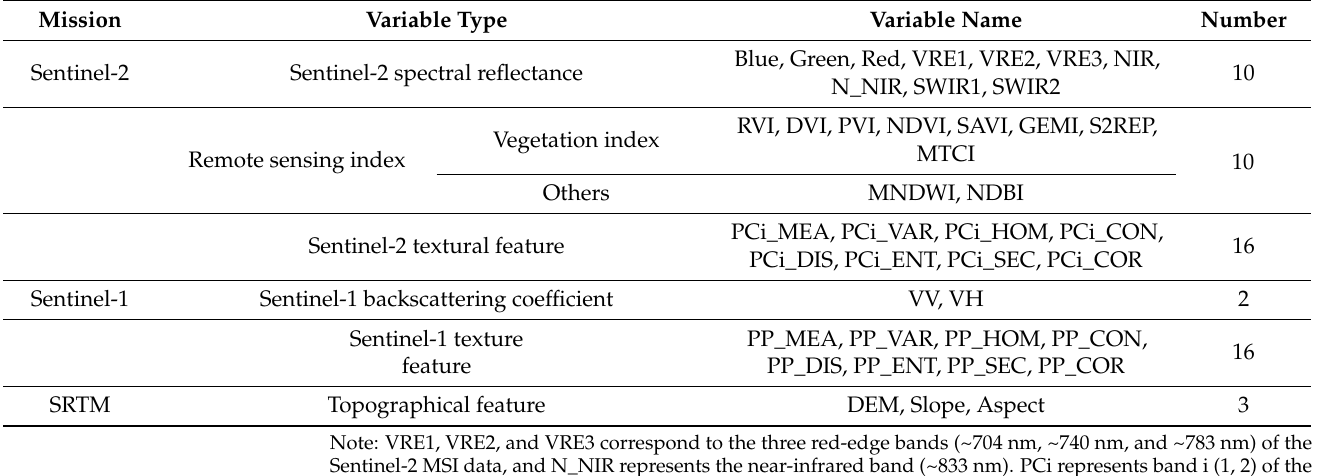
Table 2. Candidate variables for image classification and AGB